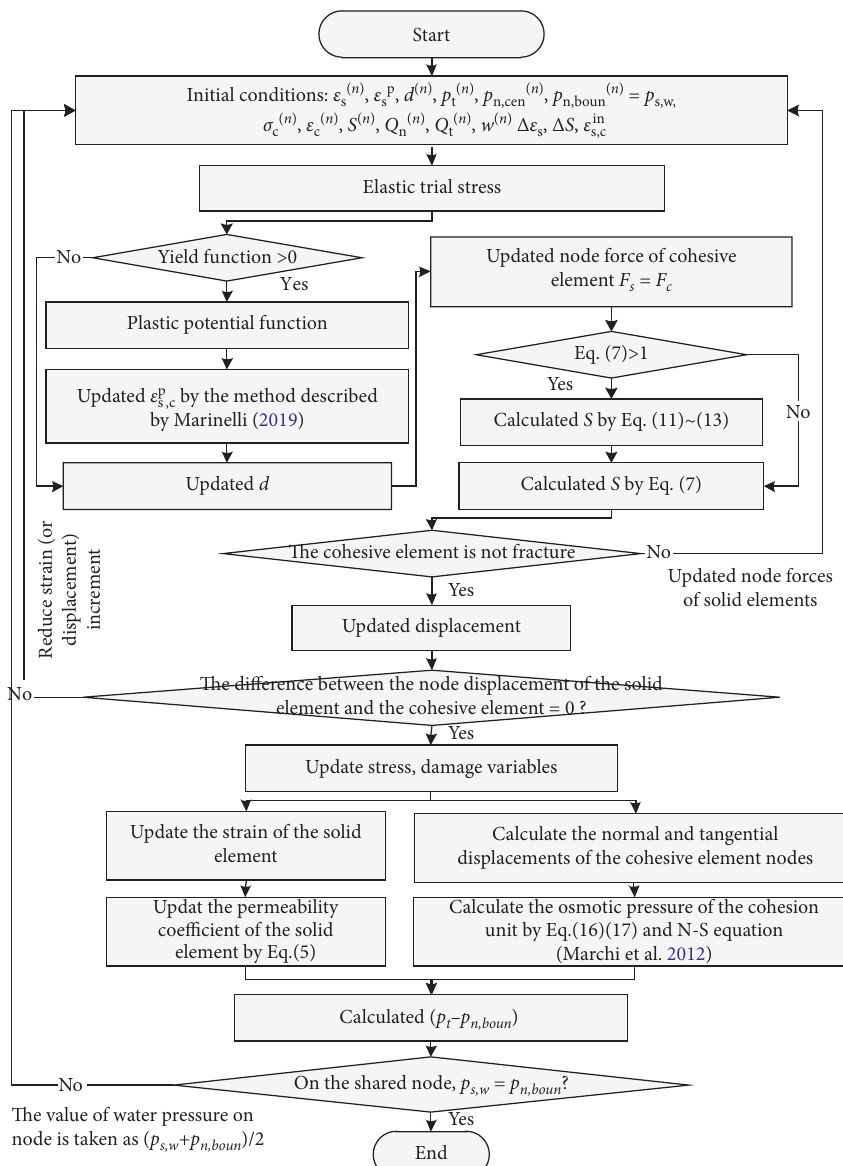
Figure 5: Numerical calculation Figure 8. The water injection point in the model was located � 0.5 m to 2.5 m from the coal-rock at the distance of D op interface, and the water injection flow was 8 m 3 /min. The − σ stress difference ( Δ σ � σ ) was set as 4, 6, and 8 MPa by v h changing the interface friction coefficient until the HF passes through the interface. The numerical results are shown in Figure 10. The numerical simulation reflects two results: (1) the stress difference Δ σ and interface friction coefficient f are c,r the key factors to determine whether HFs can cross the coal- � 0.5 m and i � 8 m 3 /min as an rock interface. Taking D w op example, when Δ σ increases from 4 MPa to 8 MPa, the critical friction coefficient f decreases from 0.22 to 0.02. c,r Under the conditions of other values of Δ σ and D , the op critical f also has similar changes. (2) D , i will have a c,r op w